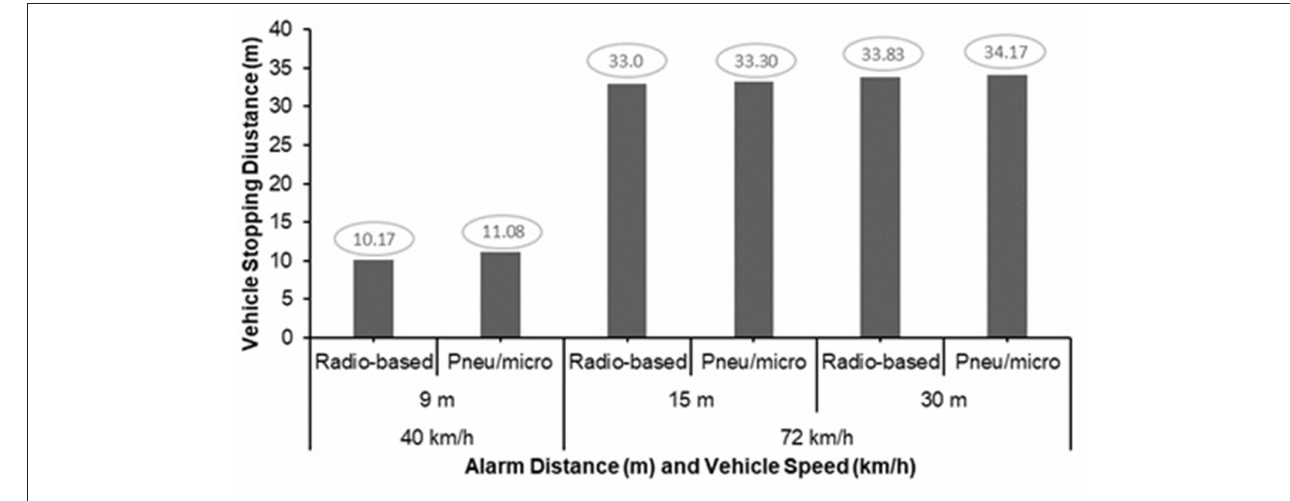
FIGURE 7 | Results of vehicle stopping distance.